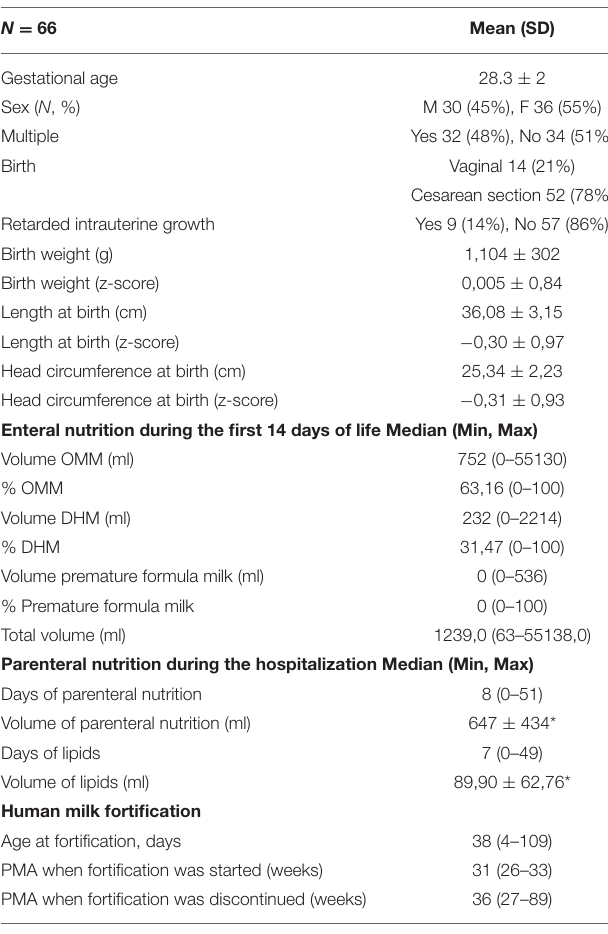
TABLE 1 | Demographic and anthropometric data of the newborns included in the study: Parenteral nutrition data during admission, enteral nutrition during the first 14 days of life, and fortification initiation and